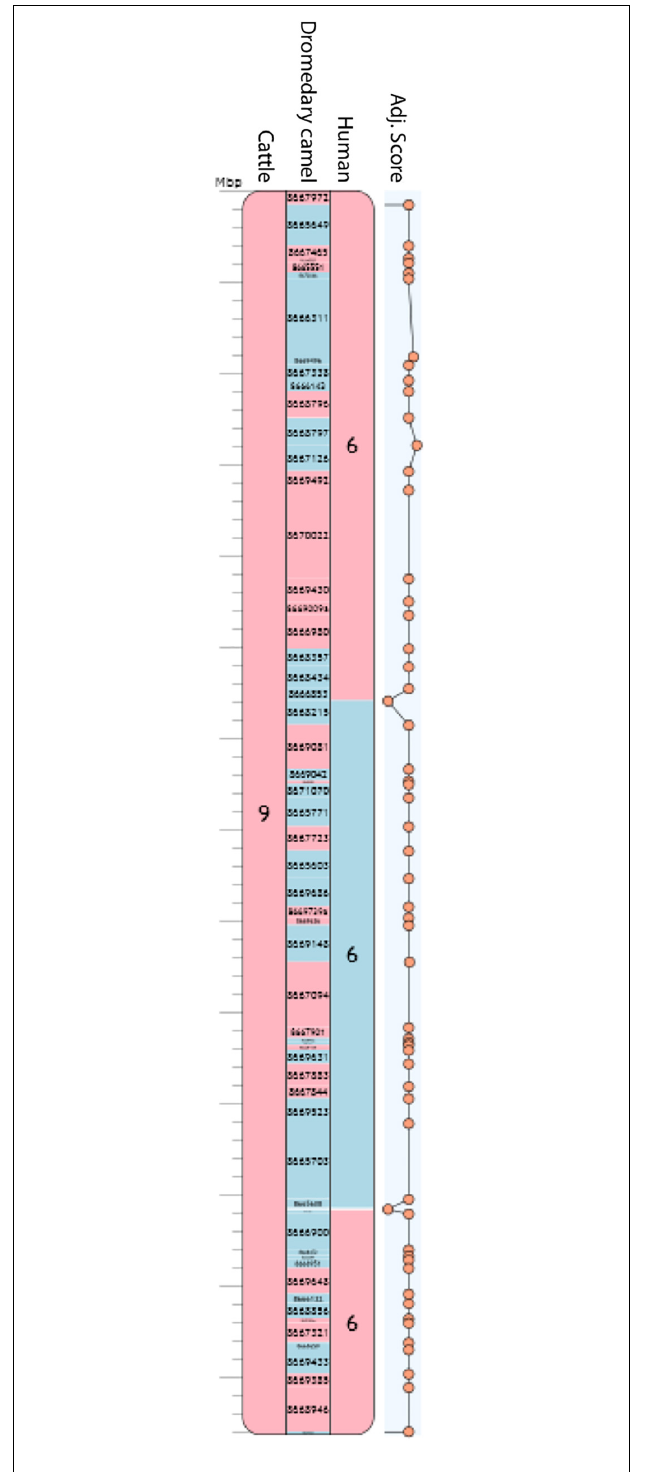
FIGURE 3 | Camel chromosome 8 corresponding to PCF 9. Blue blocks indicate positive (+) orientation of tracks compared with the camel chromosome while red blocks, negative ( − ) orientation. Numbers inside each block represent cattle and human chromosomes or dromedary scaffold IDs. Adjacency scores are shown on the right-hand side of the PCF. The rest of the chromosomes can be found in Supplementary Figure S1 .